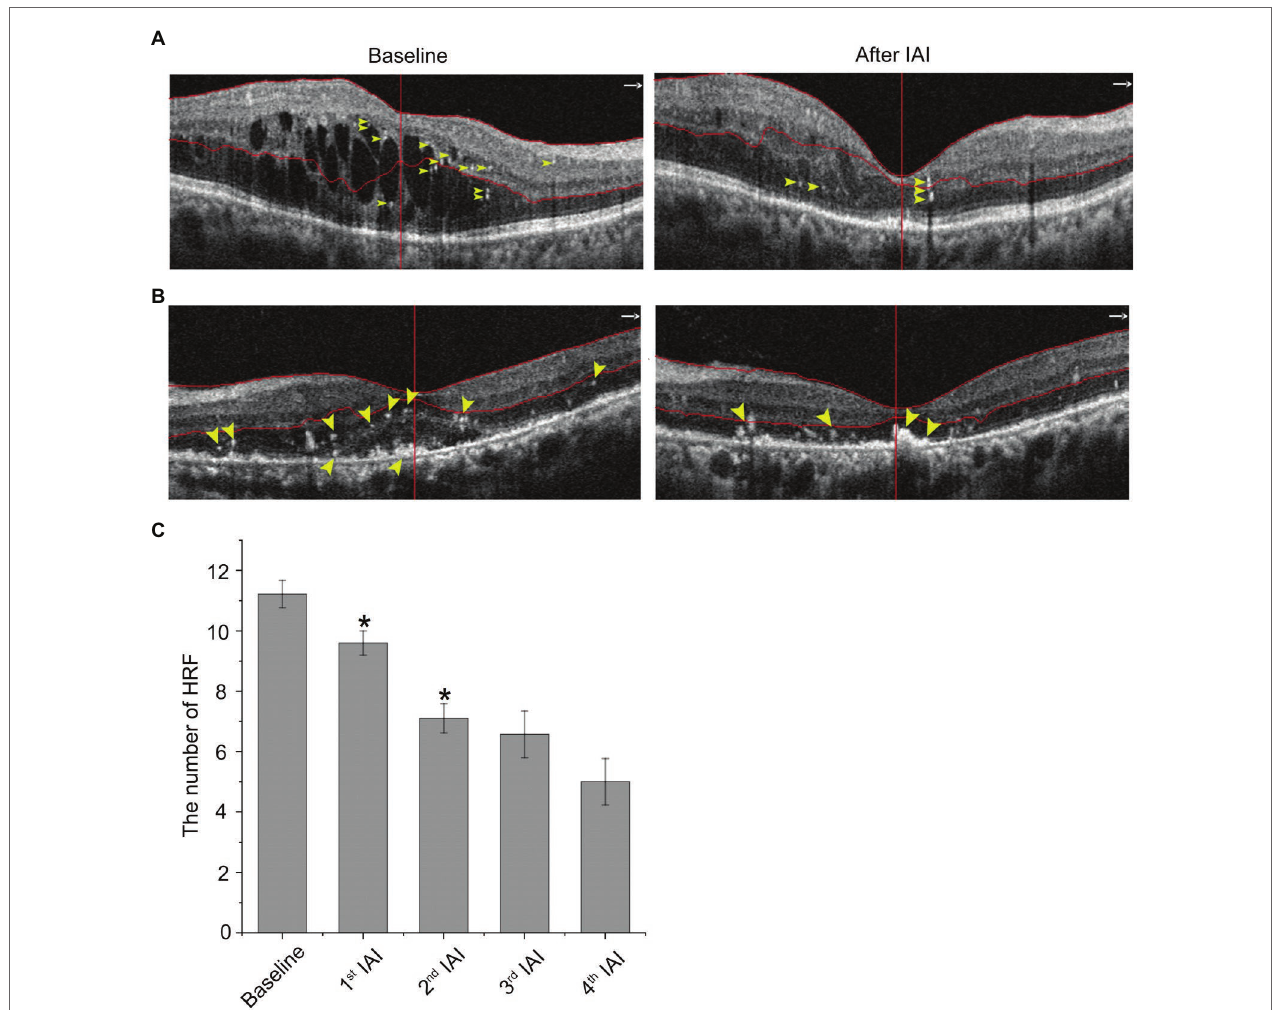
FIGURE 6 | HRF are decreased after IAI. (A) Representative images of a 30-year-old male patient with DME at baseline and after a monthly IAI. Yellow arrowheads indicate HRF, mostly around the cysts. (B) Representative images of a 70-year-old male patient with DME at baseline and after a monthly IAI. Yellow arrowheads indicate HRF, mostly around the SRF. (C) Decreased number of HRF following IAI. Data are mean ± SD. * p < 0.05 vs. baseline. HRF, hyperreflective foci; SRF, subretinal fluid; and IAI, intravitreal aflibercept injection.